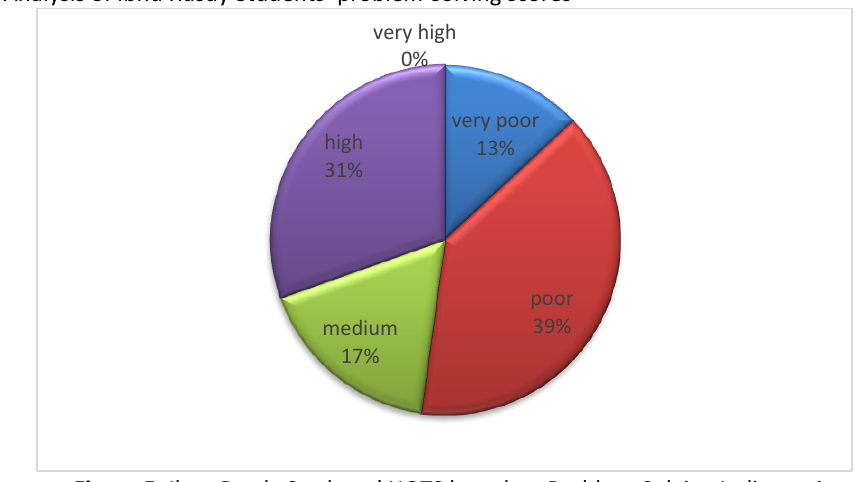
Figure 5. Ibnu Rusdy Students’ HOTS based on Problem-Solving Indicator in